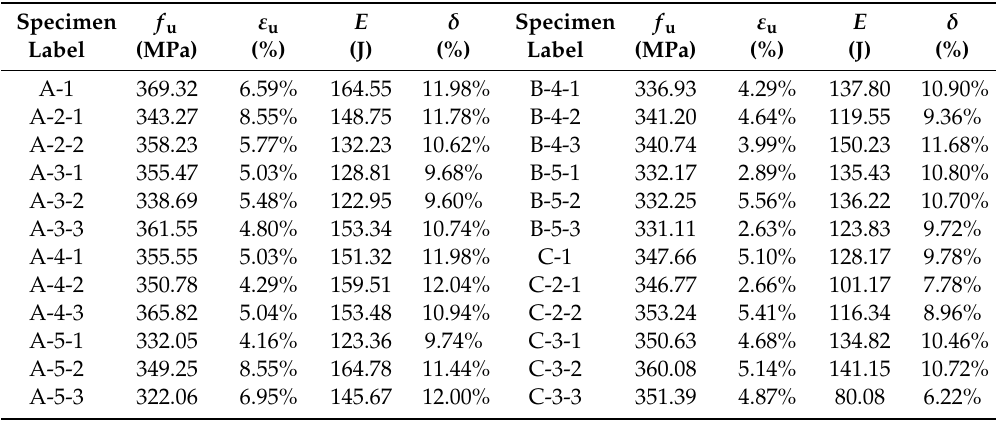
Table 2. Summary of results.